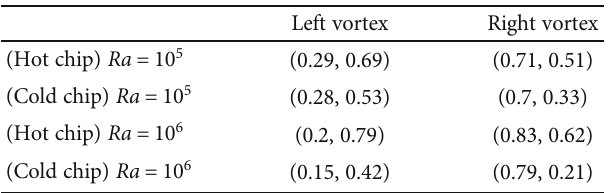
Table 3: Average Nusselt number variation for di ff erent Rayleigh